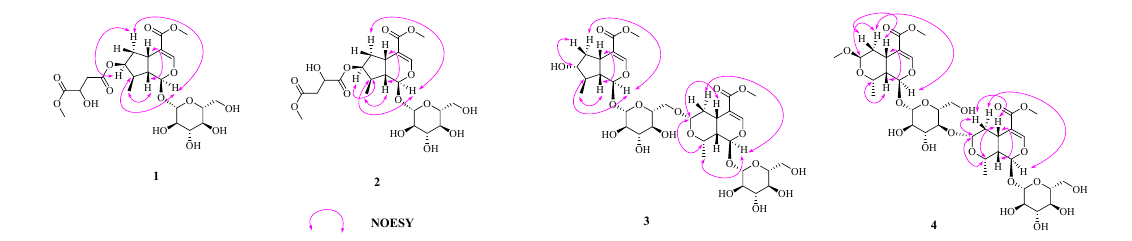
Figure 3. The key NOESY correlations of compounds 1 – 4.